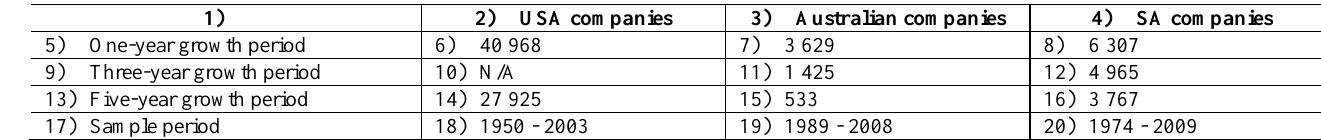
Table 1: Comparison – number of company years used in regression models